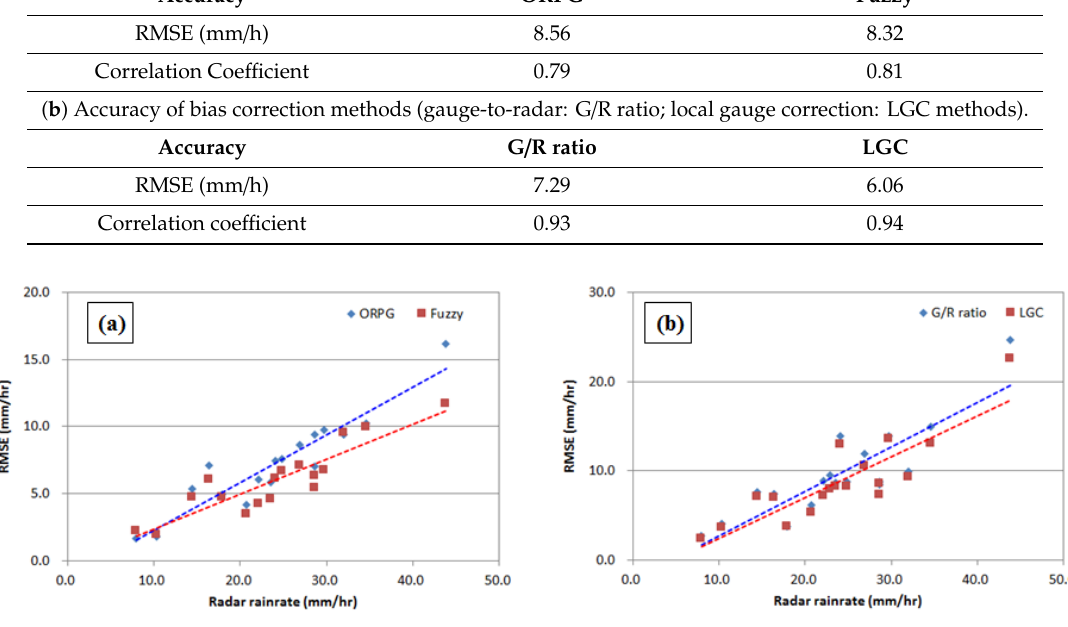
Figure 3. Q-Q (quantile-quantile) plots of RMSEs of radar-based precipitation estimates in each Figure 3. Q ‐ Q (quantile ‐ quantile) plots of RMSEs of radar ‐ based precipitation estimates in each ( a ) ( a ) quality control algorithm and ( b ) bias correction quality control algorithm and ( b ) bias correction method.